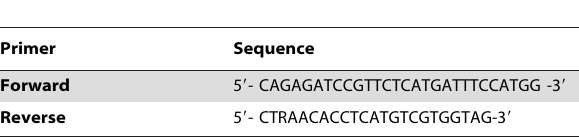
Table 1. Sequence of the novel Pkr140-5 primer